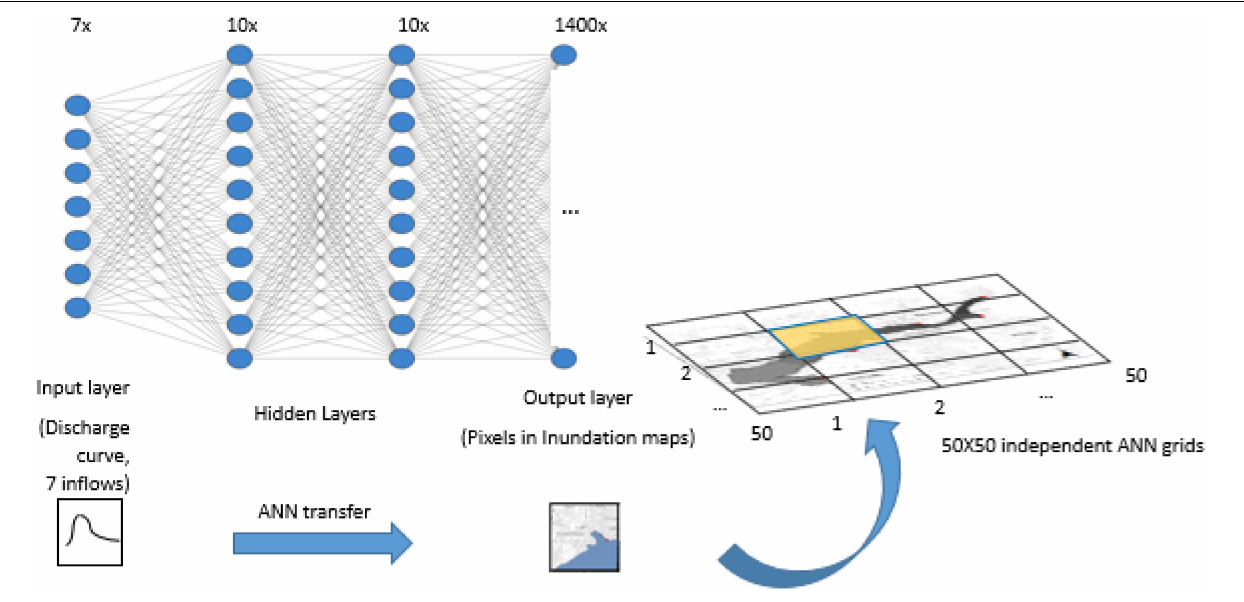
FIGURE 1 | Neural network setups. The study area is divided in 50 × 50 raster each simulated by its own ANN. Input layer: seven input hydrographs. Output layer: flood inundation extent in each